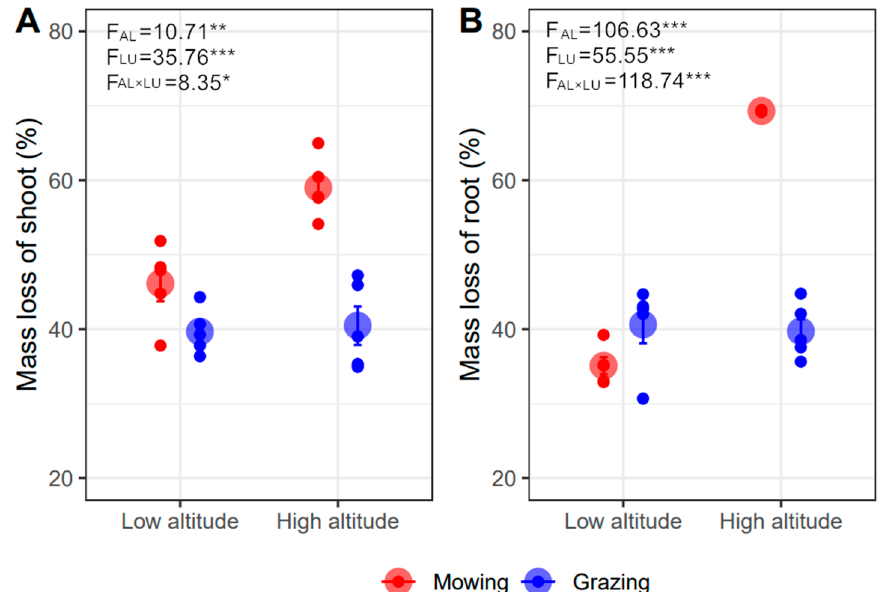
Figure 1. Effects of altitude (AL) and land-use type (LU) on shoot ( A ) and root ( B ) mass loss after one year of decomposition (Mean ± SE). The *, **, and *** represent p < 0.05, p < 0.01, and p <